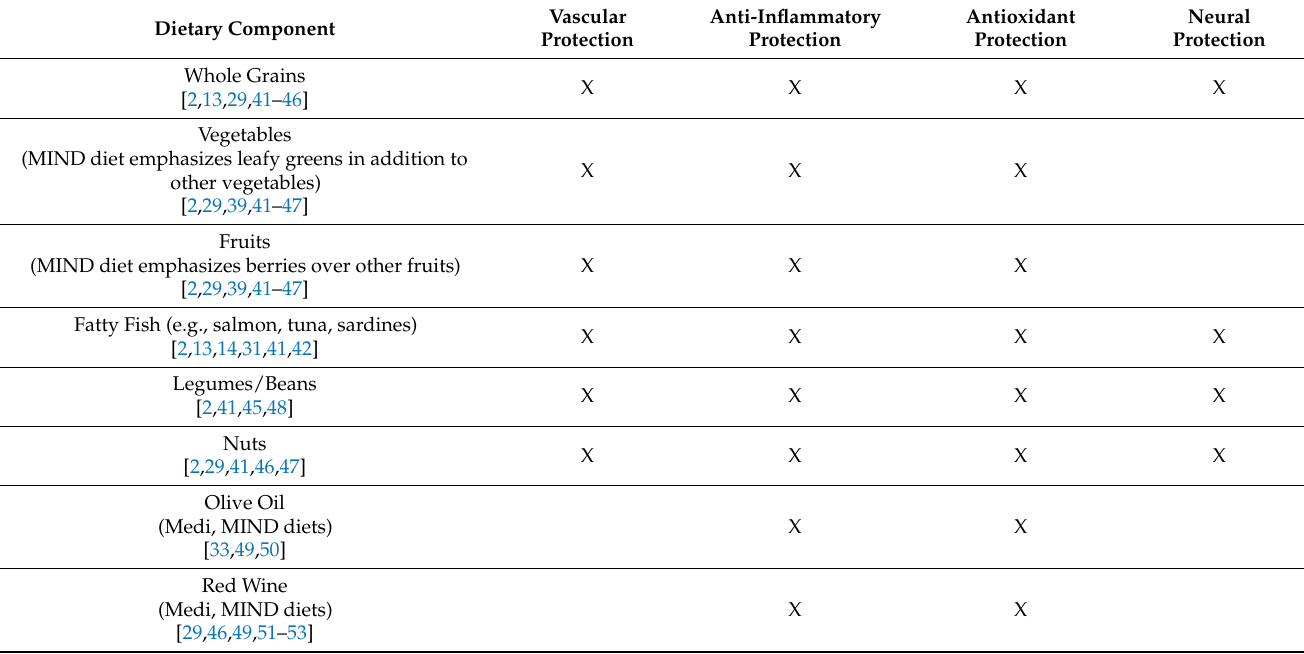
Table 1. Medi/DASH/MIND dietary components and potential neuroprotective benefits.